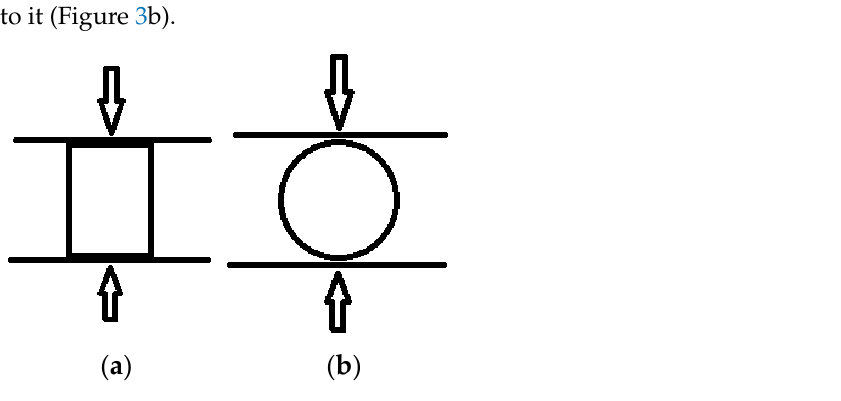
Figure 3. Sample compressive strength test scheme: ( a ) in a plane perpendicular to the axis of symmetry; ( b ) in a plane perpendicular to it.